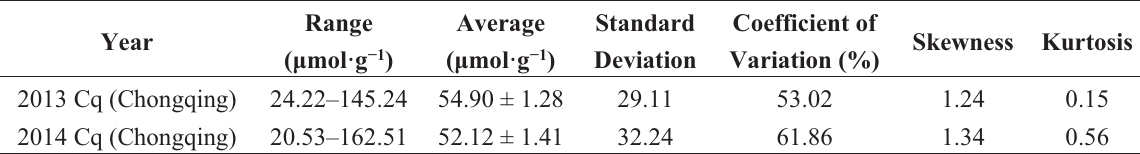
Table 1. Statistical analysis of seed glucosinolate content in 520 rapeseed